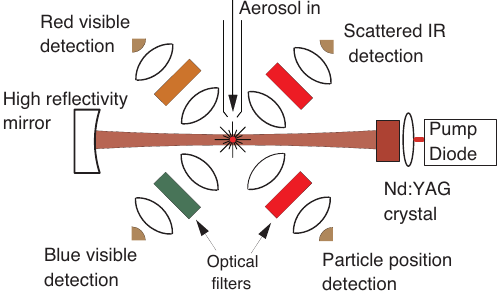
Figure A3. Schematic diagram of the SP2 photometer showing the basic optics and laser-induced incandescence and scattering detec-